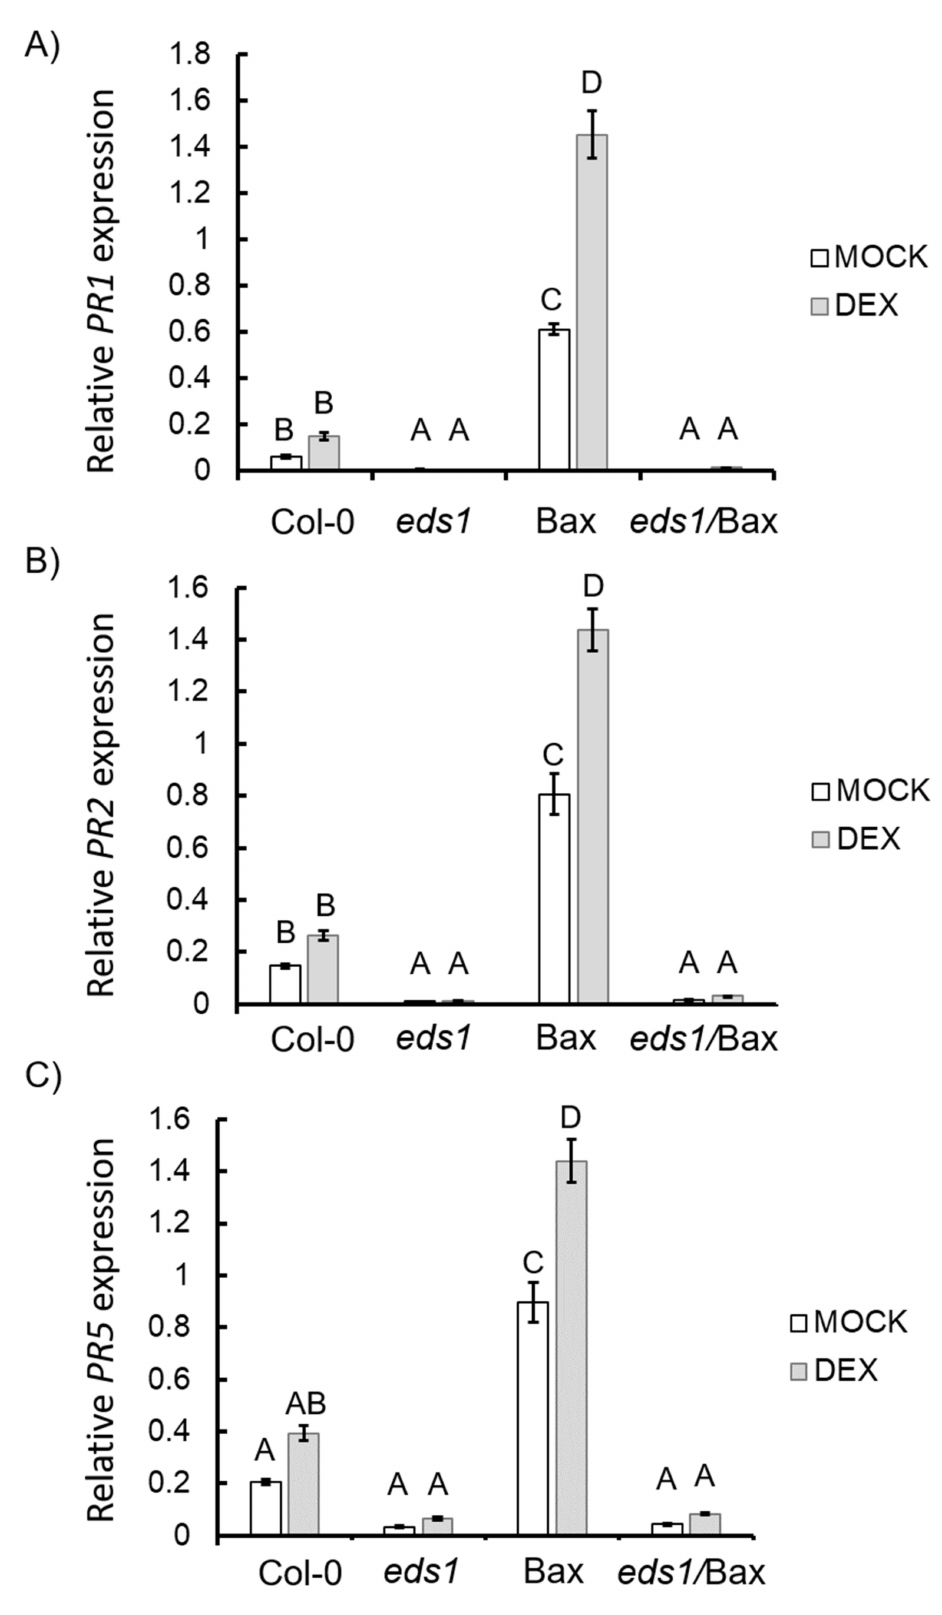
Figure 5. Relative expression levels of hypersensitive response (HR) marker genes in the wildtype, eds1 mutant, andBaxand eds1 / Baxlines: ( A ) PR1 , ( B ) PR2 , and ( C ) PR5 . Withinasubgraph, valuessharing common labels (letters) are not significantly di ff erent from each other ( p > 0.001) ( n =